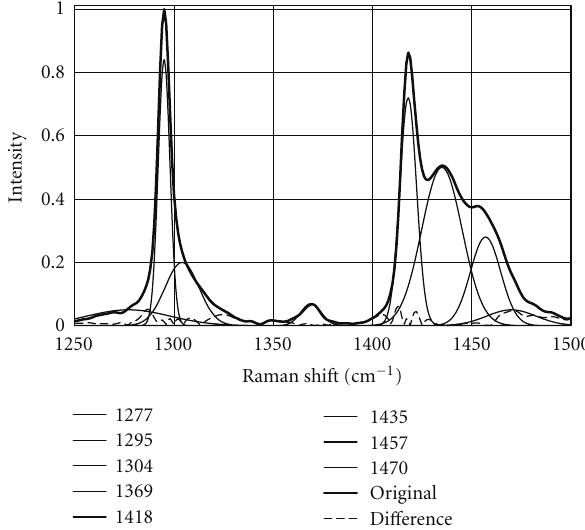
Figure 4: Gauss deconvolution of Raman spectra (Sample